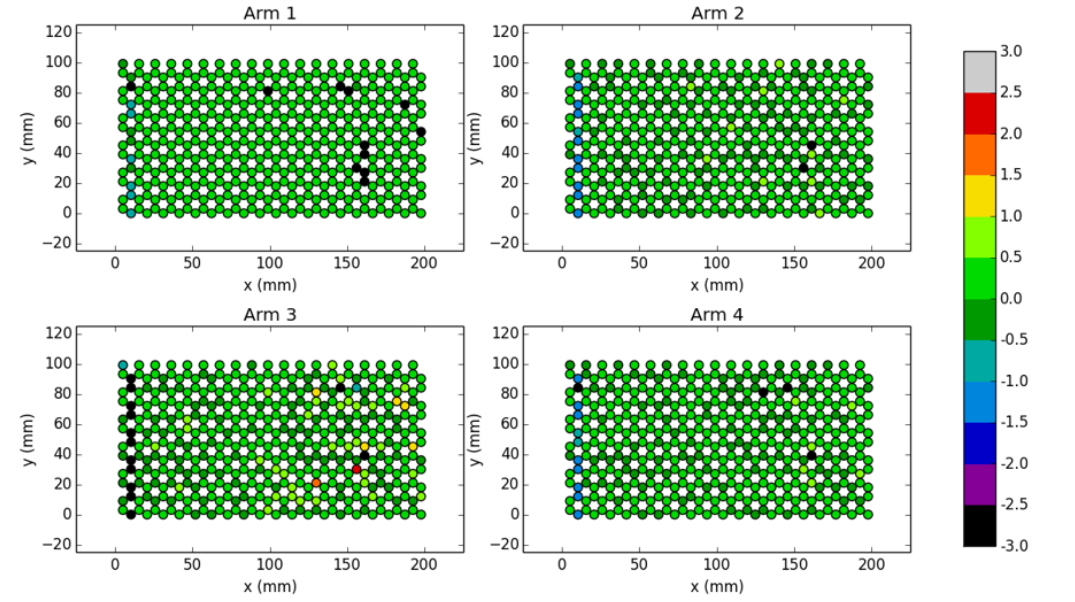
Figure A7. Subset analysis of variances in arm length with respect to target length. Spirals arranged as they are